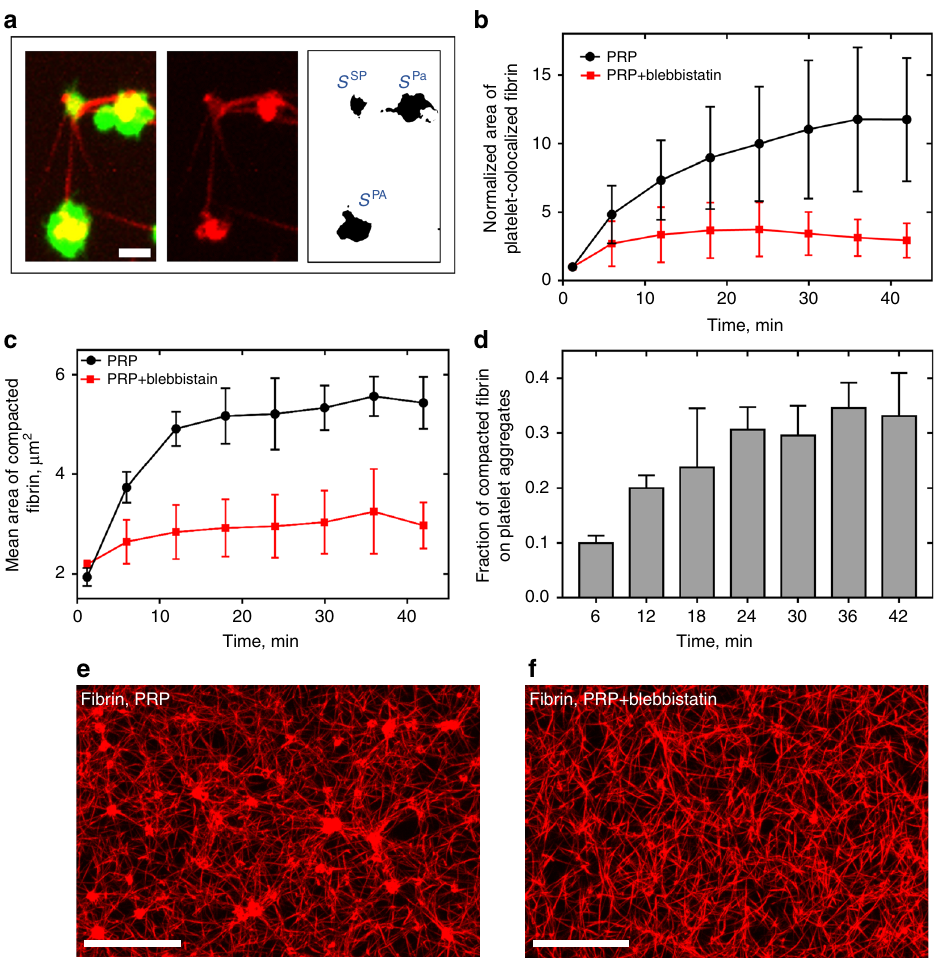
Fig. 2 Platelet-induced fi brin compaction. ( a , left ) : a confocal image of platelets ( green ) and fi brin ( red ); ( a , center ): fi brin fi bers and patches (compacted fi brin); ( a , right ): fi brin co-localized with platelets. Compaction of fi brin by a single cell ( S SP ) and by two platelet aggregates ( S PA ) is shown; scale bar : 3 μ m. b , c Changes in the total area of platelet-associated fi brin normalized to its initial value b and the mean absolute area of platelet-co-localized fi brin ( c ) during the course of clot contraction (mean ± SEM). d Relative portion of fi brin material compacted by platelet aggregates, mean ± SEM, n > 200. The analyzed volume size is 217 µ m × 217 µ m × 34 µ m. e , f Confocal images of a fi brin network in a PRP-clot formed and allowed to contract in the absence ( e ) and presence ( f ) of blebbistatin (300 µ M). Scale bar : 30 μ (Fig. 3c) from 30.2 ± 3.6 to 40.9 ± 18.8 µ m 2 ( P = 0.008, a two- aggregates become more ef fi cient in fi brin remodeling at the later stages of clot contraction forming large patches of compacted tailed Mann − Whitney test). This secondary enlargement of fi brin. platelet aggregates incorporated into fi brin likely results in generation of a higher contractile force that would promote clot contraction at the later stages.